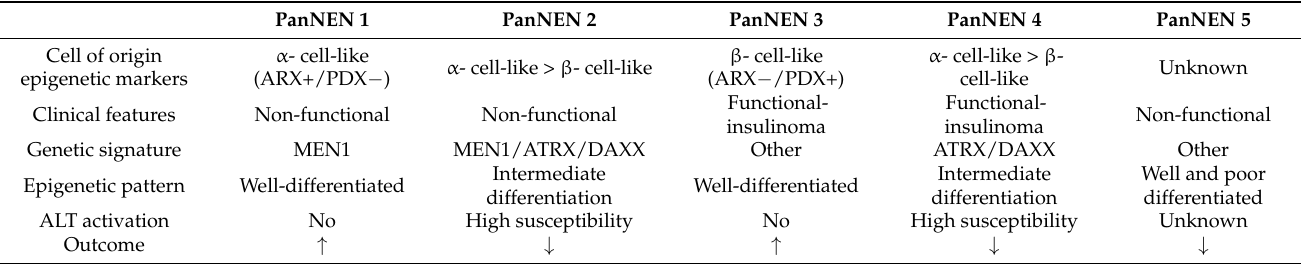
Table 2. Schematic indicators for pancreatic neuroendocrine neoplasms classification using genetic and epigenetic signatures 1